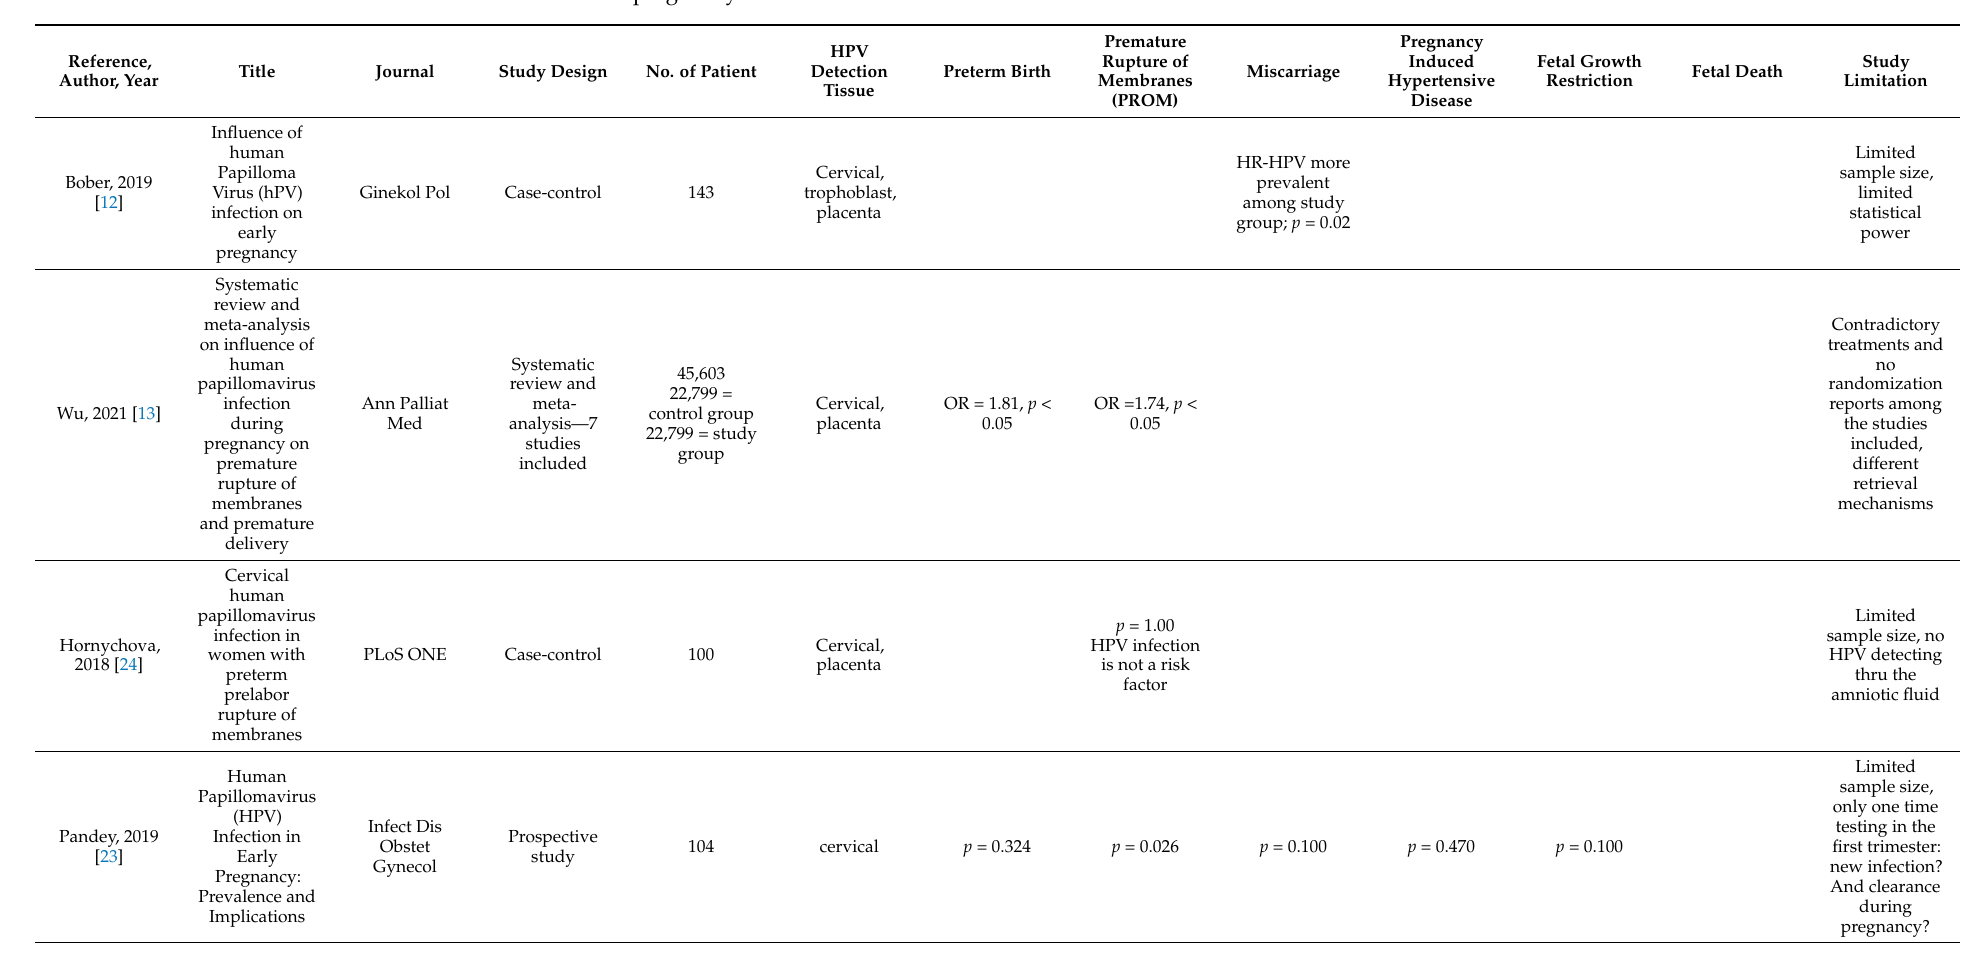
Table 1. Included studies—pregnancy outcomes and